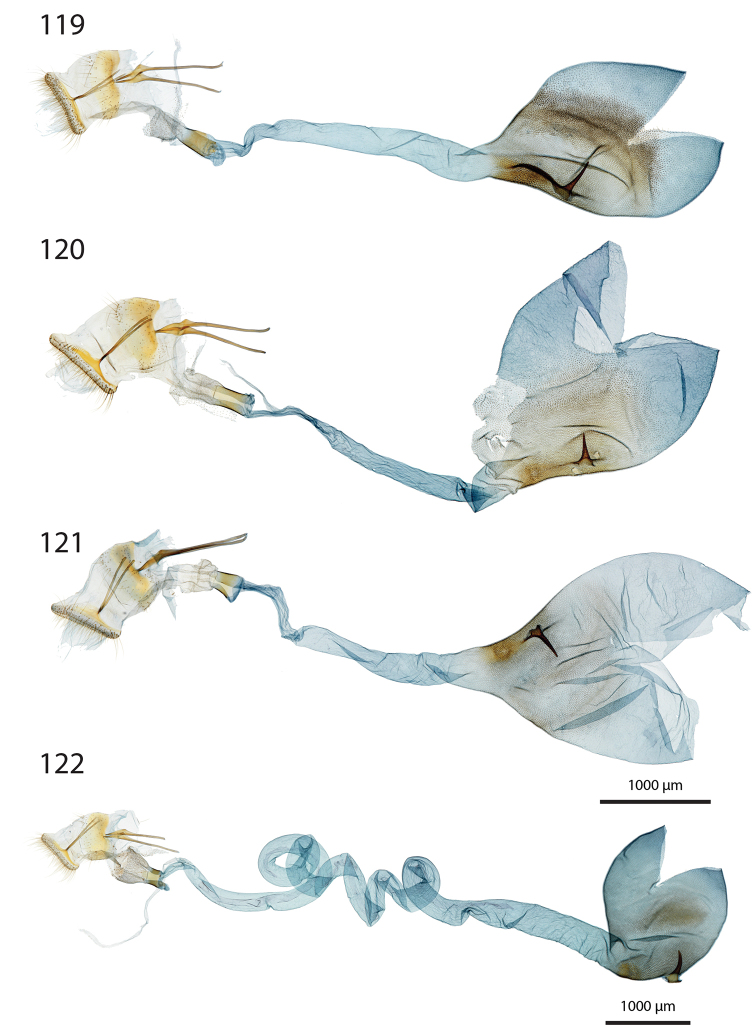
Female genitalia features of Hoploscopa. 119Hoploscopa
boleta sp. nov., paratype, TL448 ♀ 120Hoploscopa
pseudometacrossa sp. nov., paratype, TL435 ♀ 121Hoploscopa
metacrossa, paratype, TL446 ♀ 122Hoploscopa
jubata sp. nov., paratype, TL445 ♀.